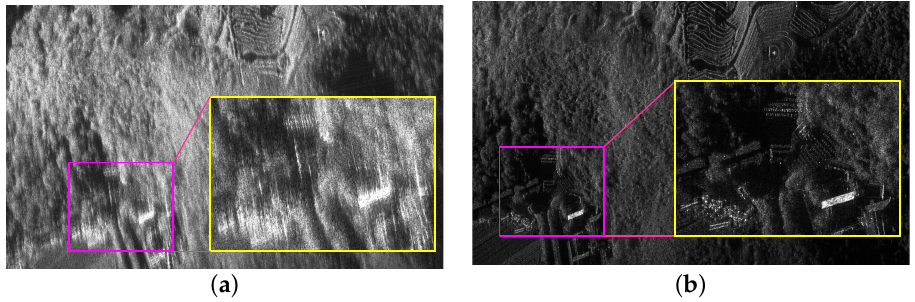
Figure 17. Comparison of data processing results of ETSA ( a ) and IETSA ( b ). Similar to the point target simulation, the squint angle and coherent integration angle of the experimental data are 7.2° and 5°,